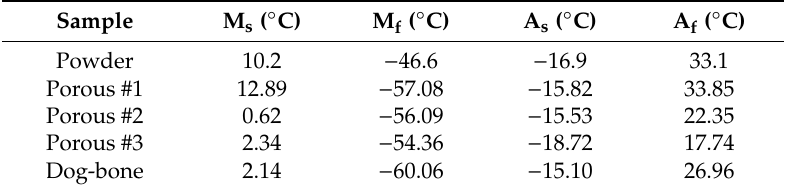
Table 4. The transformation temperatures (TTs) of powder, dog-bone, and the porous samples.